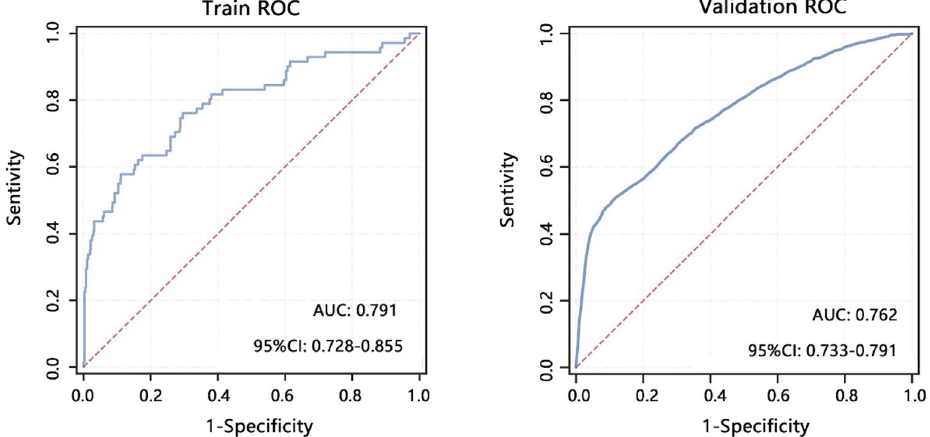
Figure 3. ROC analysis was used to assess the performance of the comprehensive model in training and validation